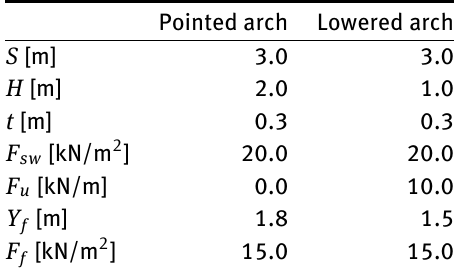
Table 1: Geometric and loading parameters of the pointed and lowered arches taken as examples.